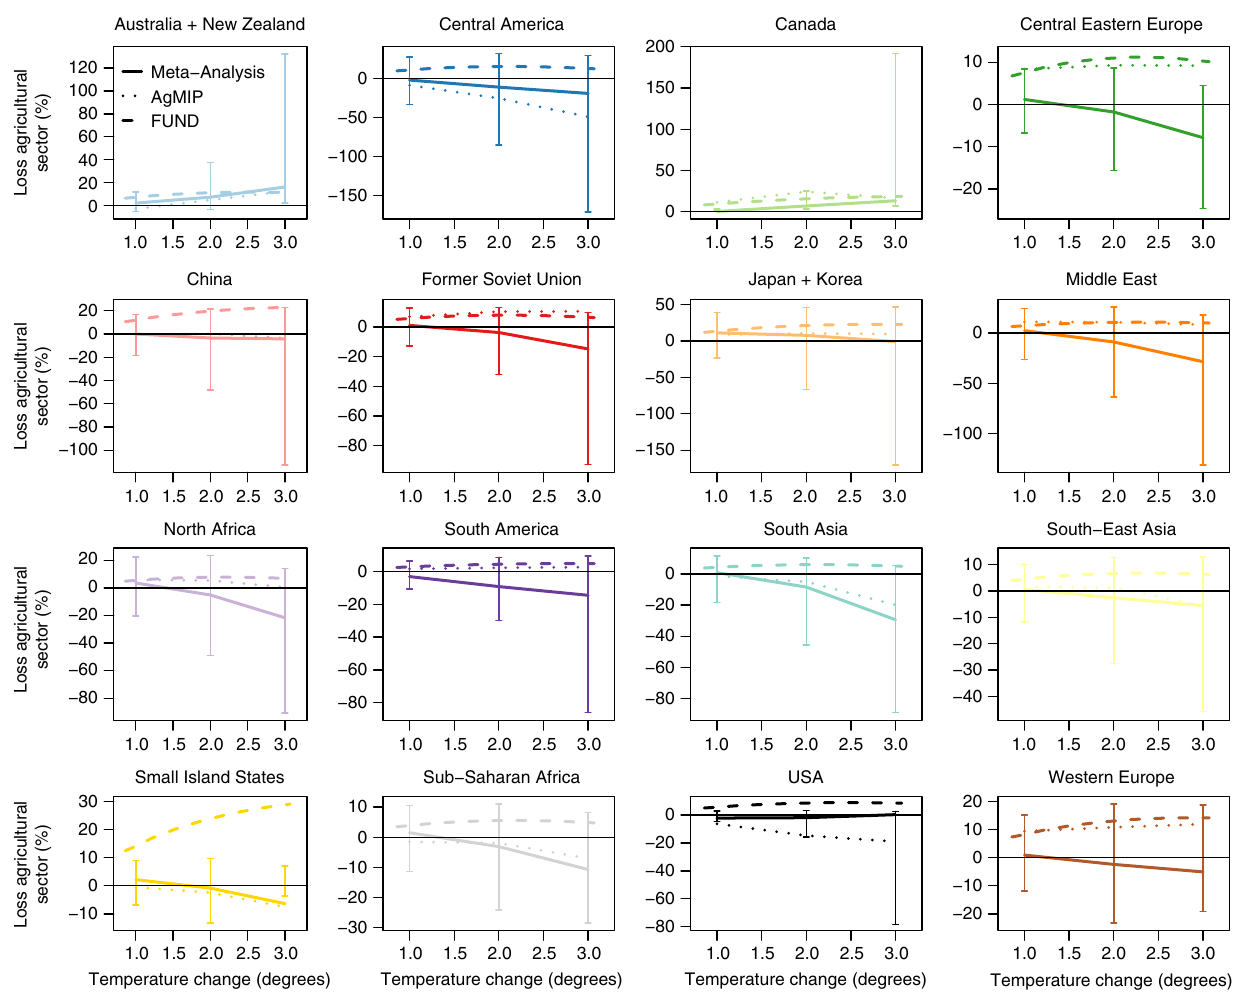
Fig. 3 Three agriculture-sector damage functions for each of the 16 FUND regions. Solid lines are from meta-analysis results, dotted lines are AgMIP results, and dashed lines are the existing FUND damage functions. Error bars show the damage functions based on the 2.5th and 97.5th quantiles of the meta-analysis results. Temperature changes are global averages and are relative to a global average 1995 – 2005 baseline. A version of the fi gure excluding error bars, which allows differences in the point-estimates to be more easily distinguished, is given in Supplementary Fig.